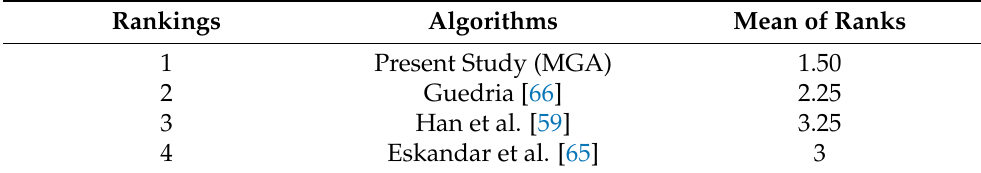
Table A8. Friedman statistical test results for the welded beam design